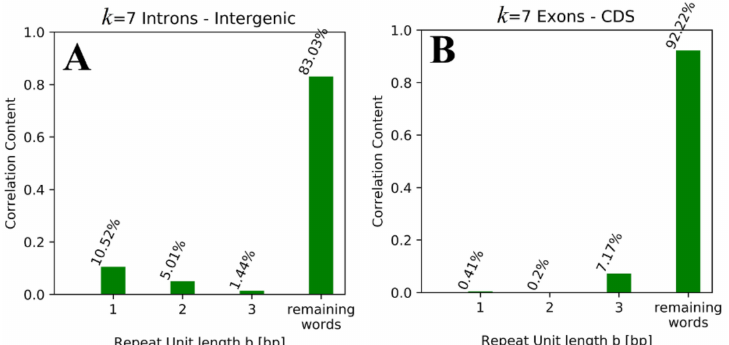
Figure 3. Histograms representing the correlation contributions of tandem repeat k -mer words with different repeat unit lengths to k = 7 correlation values for intron–intergenic correlation ( A ) and to exon–CDS correlation ( B ) (see Section 2.2 for